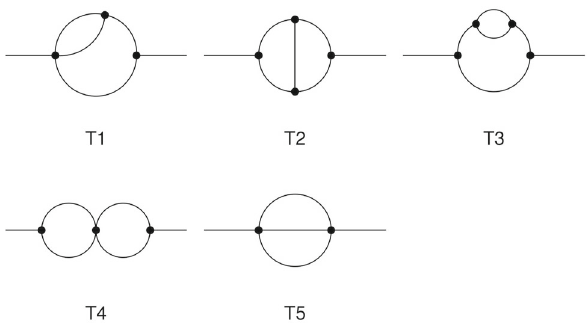
Fig. 2 Two-loop topologies for two-point functions